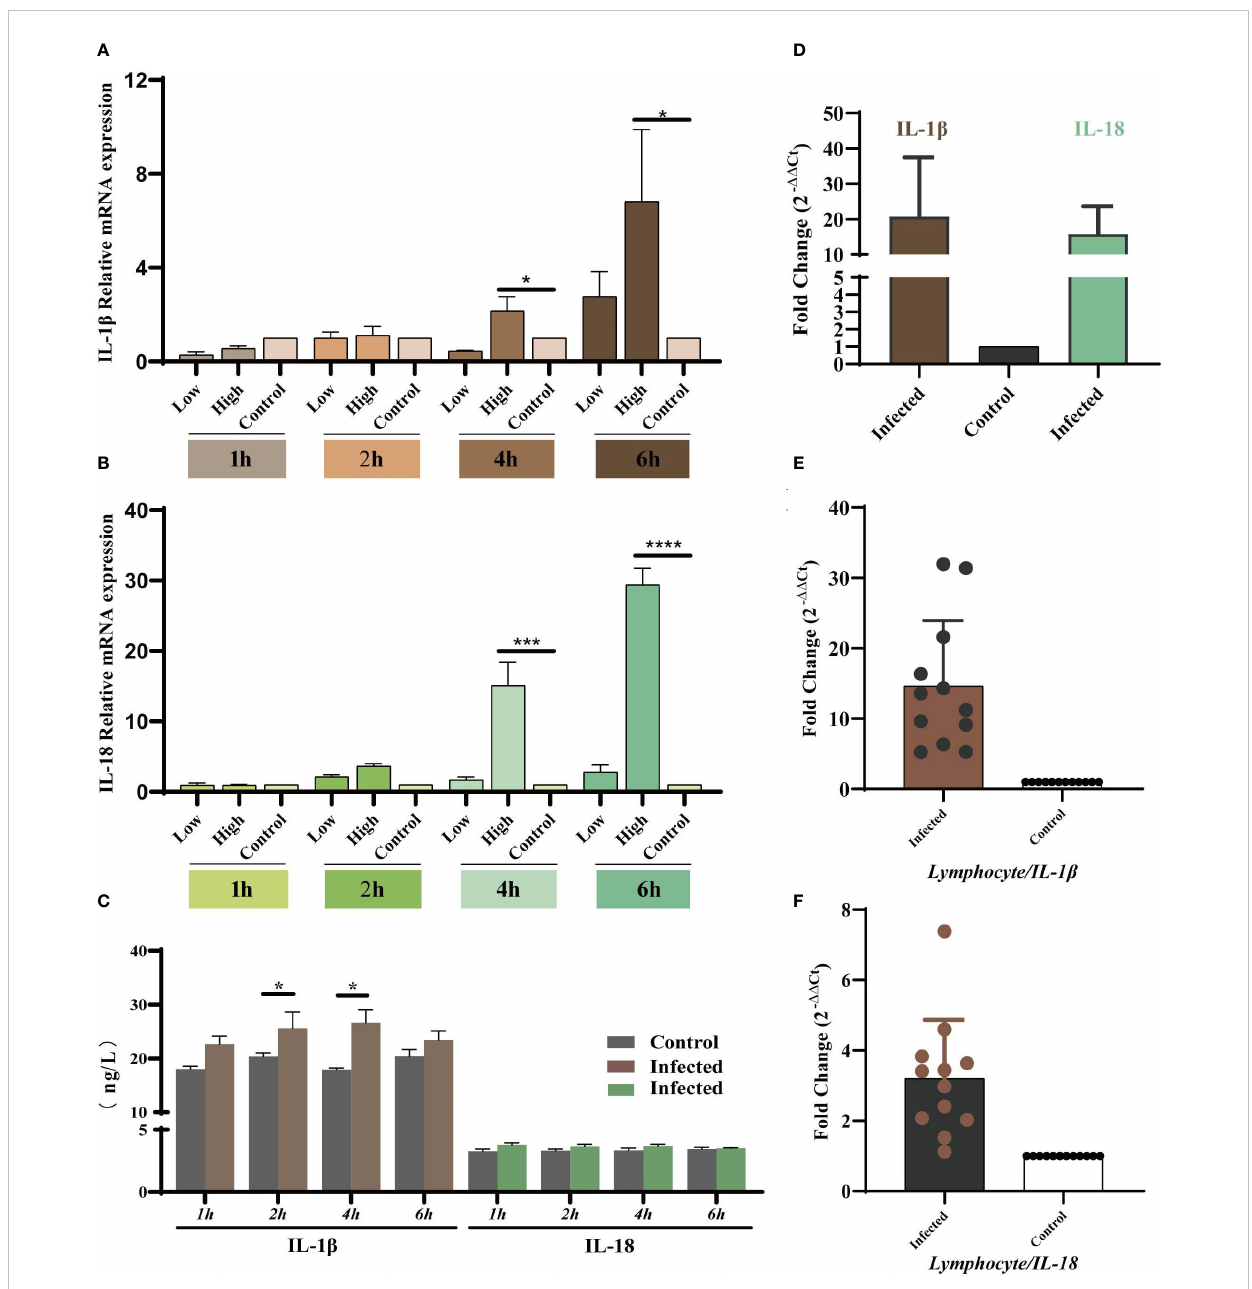
FIGURE 4 YT strain infection increases levels of IL-1 b and IL-18 mRNA expression and secretion in vitro and in vivo . (A) IL-1 b gene expression levels at different times post-infection measured using qRT-PCR assays. (B) IL-18 gene expression levels at different times post-infection measured using qRT-PCR assays. (C) IL-1 b and IL-18 levels at different times post-infection detected using ELISA. (D) The mRNA expression levels of IL-1 b and IL-18 in the liver tissue detected using qPCR. (E, F) The mRNA expression levels of IL-1 b and IL-18 lymphocytes compared with control group. Symbols indicate comparison vs. control group; *P < 0.05, ***P < 0.001 and ****P <